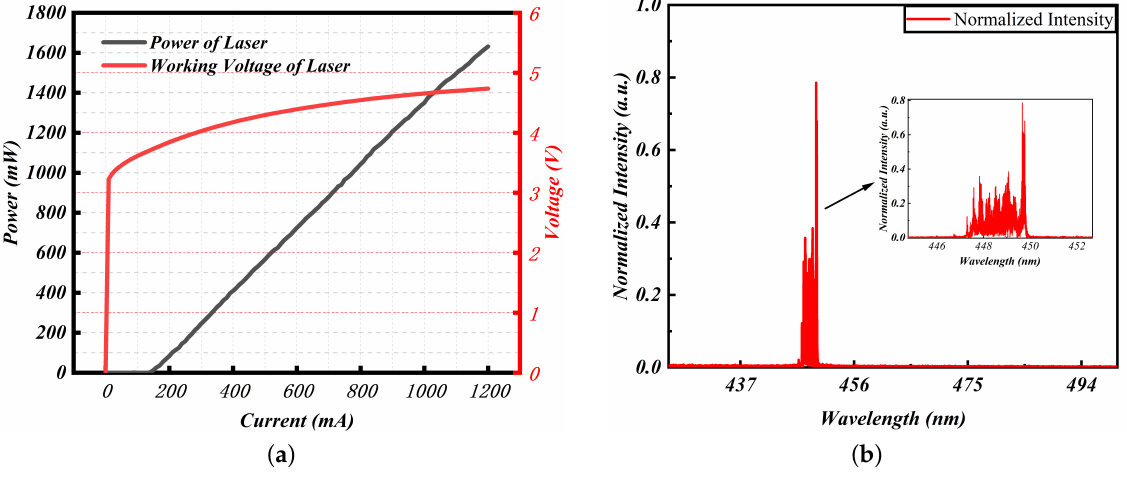
Figure 5. Spectrum and L-I-V of the laser ( a ) L-I-V of the laser; ( b ) The spectrum of the laser. In the system, the square wave is used to modulate the excited light. During the modulation process, the duty ratio of the square wave will affect the intensity of the photoacoustic signal. The relationship between the duty cycle and the signal strength is studied. We use a signal generator (DG 3101A, RIGOL, Beijing, China) to apply a square wave modulated signal to the current controller (ITC4005-QCL, Thorlabs). Then the study starts with modulating the light to a specific frequency 3180 Hz corresponding to the resonance frequency of the photoacoustic cell. Then the duty cycle of the square wave at two different concentrations is changed with collecting the photoacoustic signal in the meantime. The test results are shown in Figure 6. From the results, it can be found that the photoacoustic signal reaches the maximum value when the duty cycle is 50%. So the duty cycle of the square wave in the system is set to